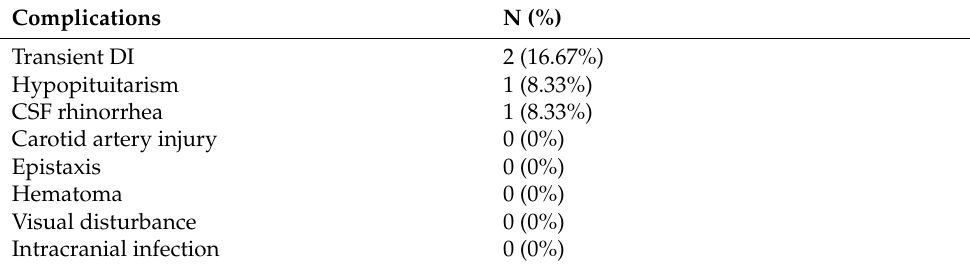
Table 2. Postoperative complications of the patients who underwent ETS.